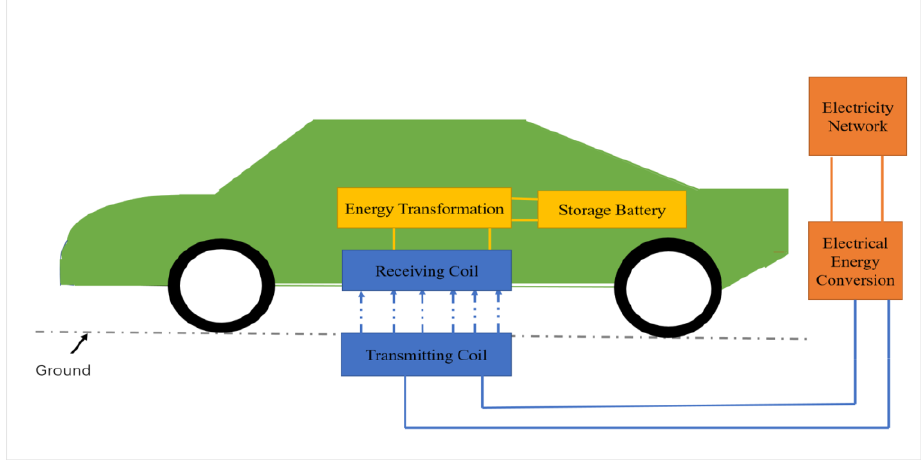
Figure 1. Schematic diagram of the wireless charging system for electric vehicles.